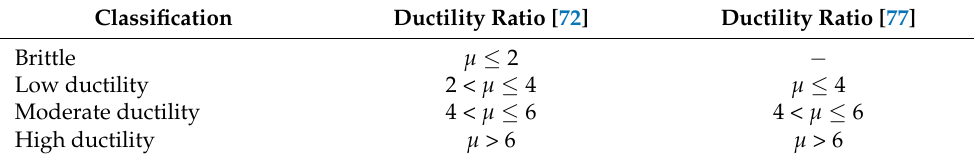
Table 5. Classification of ductility